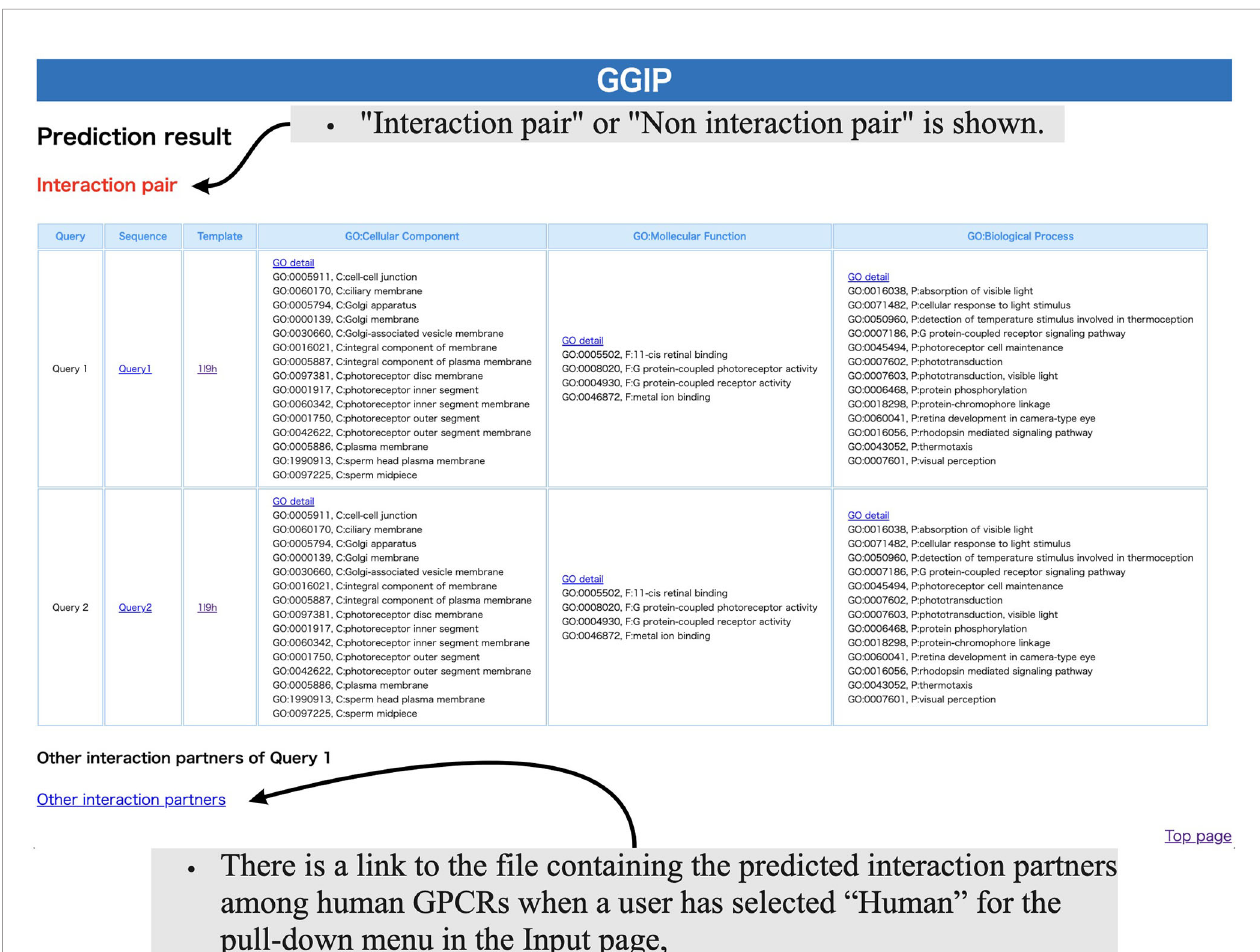
FIGURE 3 | Results page of